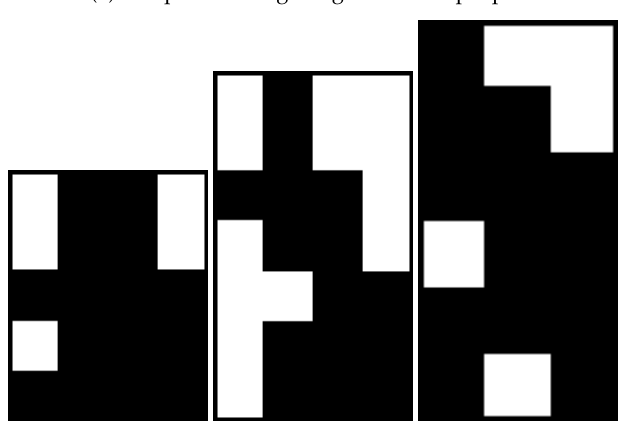
( b ) Sample resulting image three people. Figure 10. Separate RoIs extracted as binary